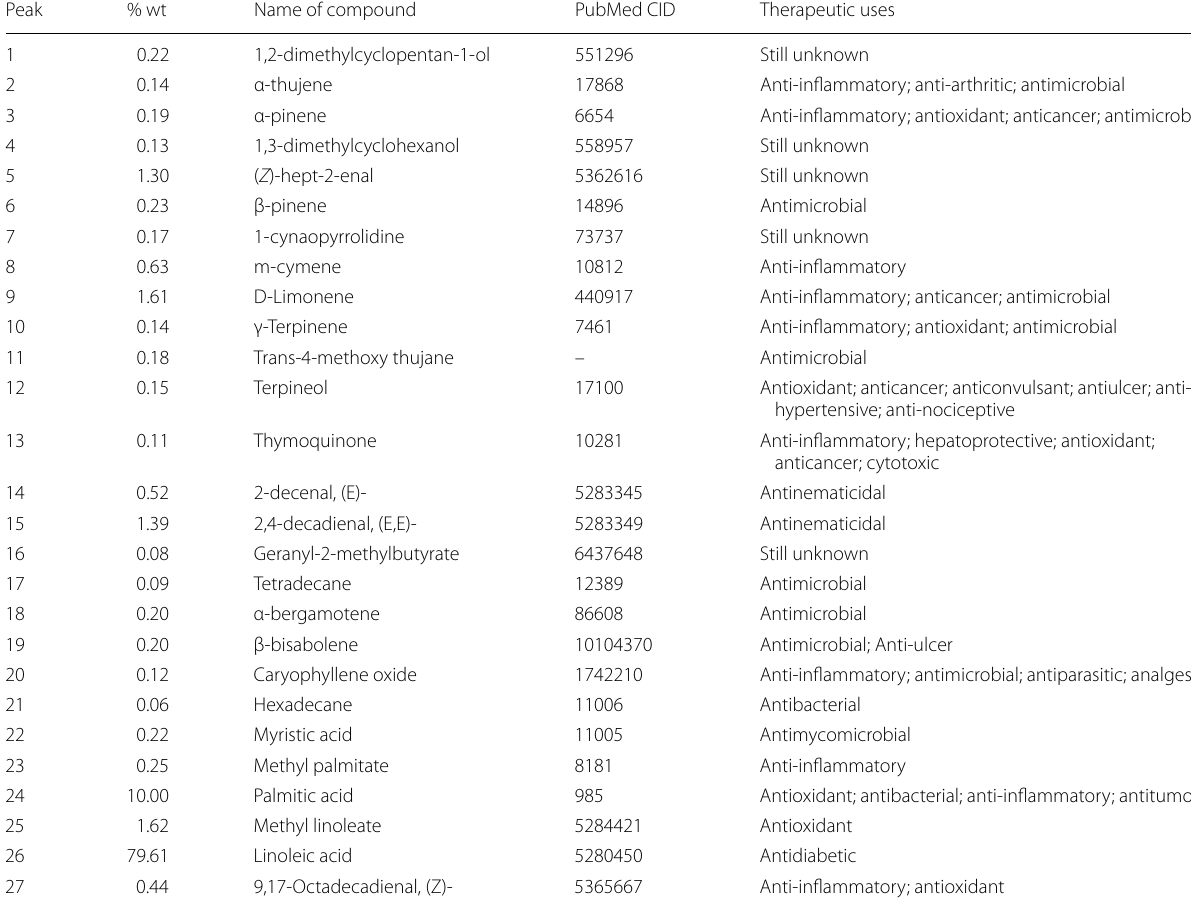
Table 1 Phytochemical compounds identified in N. sativa seed oil Peak